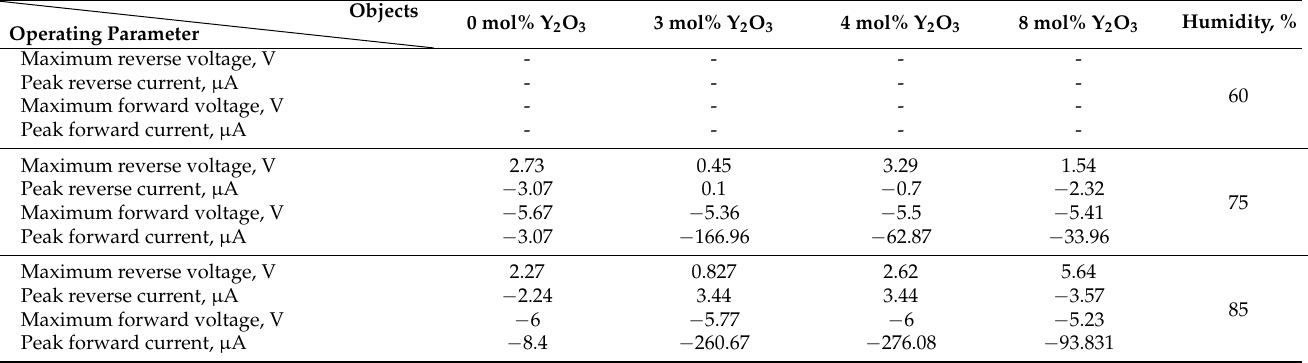
Table 2. Limit parameters model of curves depending on the percentage of Y 2 O 3